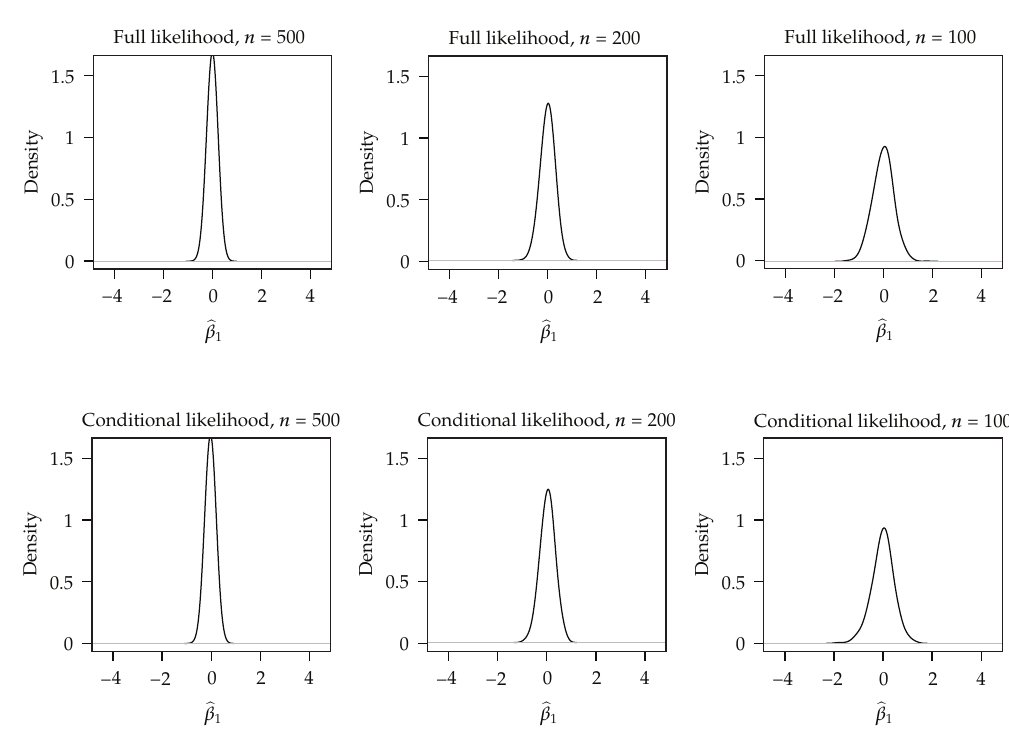
Figure 6: Sampling distributions for maximum likelihood estimates of regression coe ffi cient β 1 from 1000 replications; NPQM model fitted to NPQM data (cid:5) Y i ∼ NPQM (cid:5) 4 , 2 , 0 . 15 , 0 . 14 (cid:6)(cid:6)